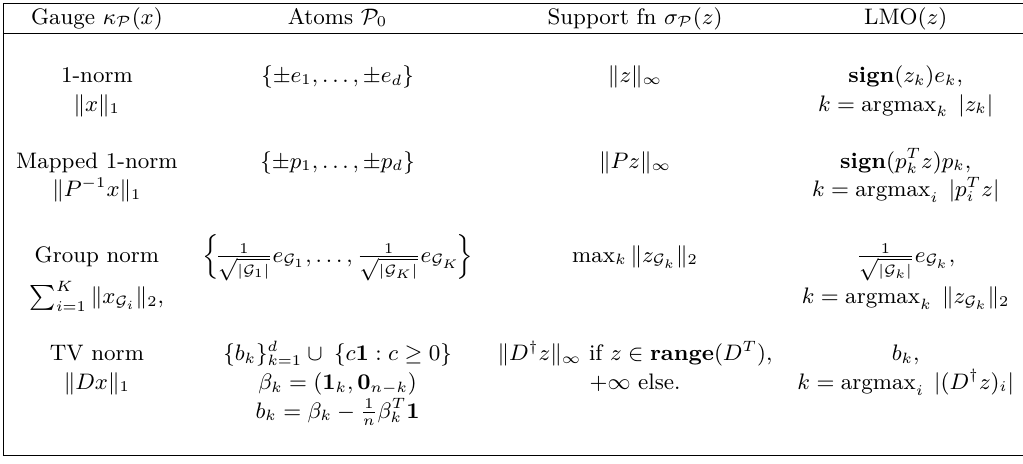
Table 2 Common norms, their atoms, support functions, and their LMOs. In particular, computing each LMO is computationally cheap, especially compared to computing the proximal operator of the gauge, or even the gauge